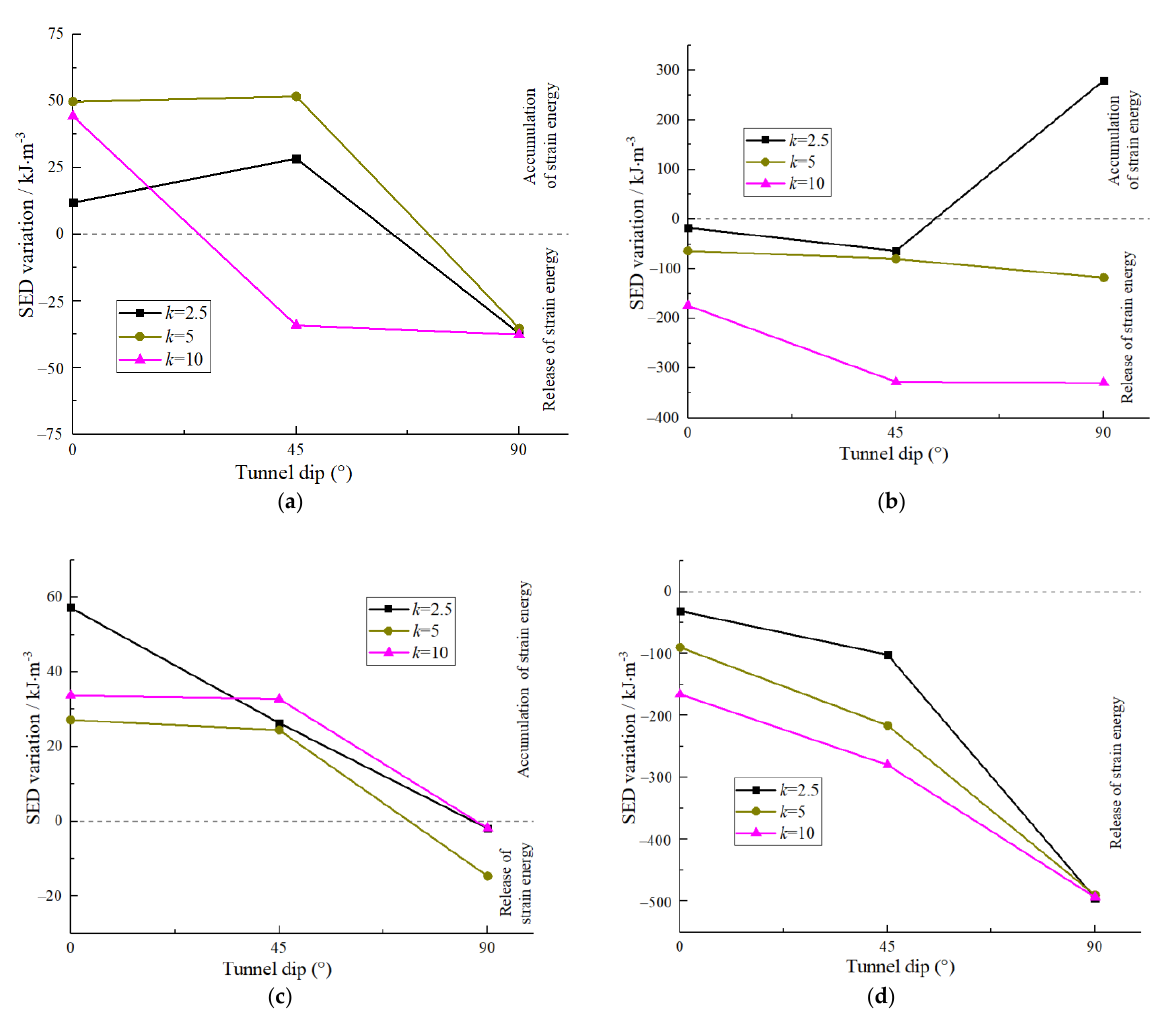
Figure 13. Variation of strain energy density before and after blasting: ( a ) B1; ( b ) B2; ( c ) B3; ( d ) B4.